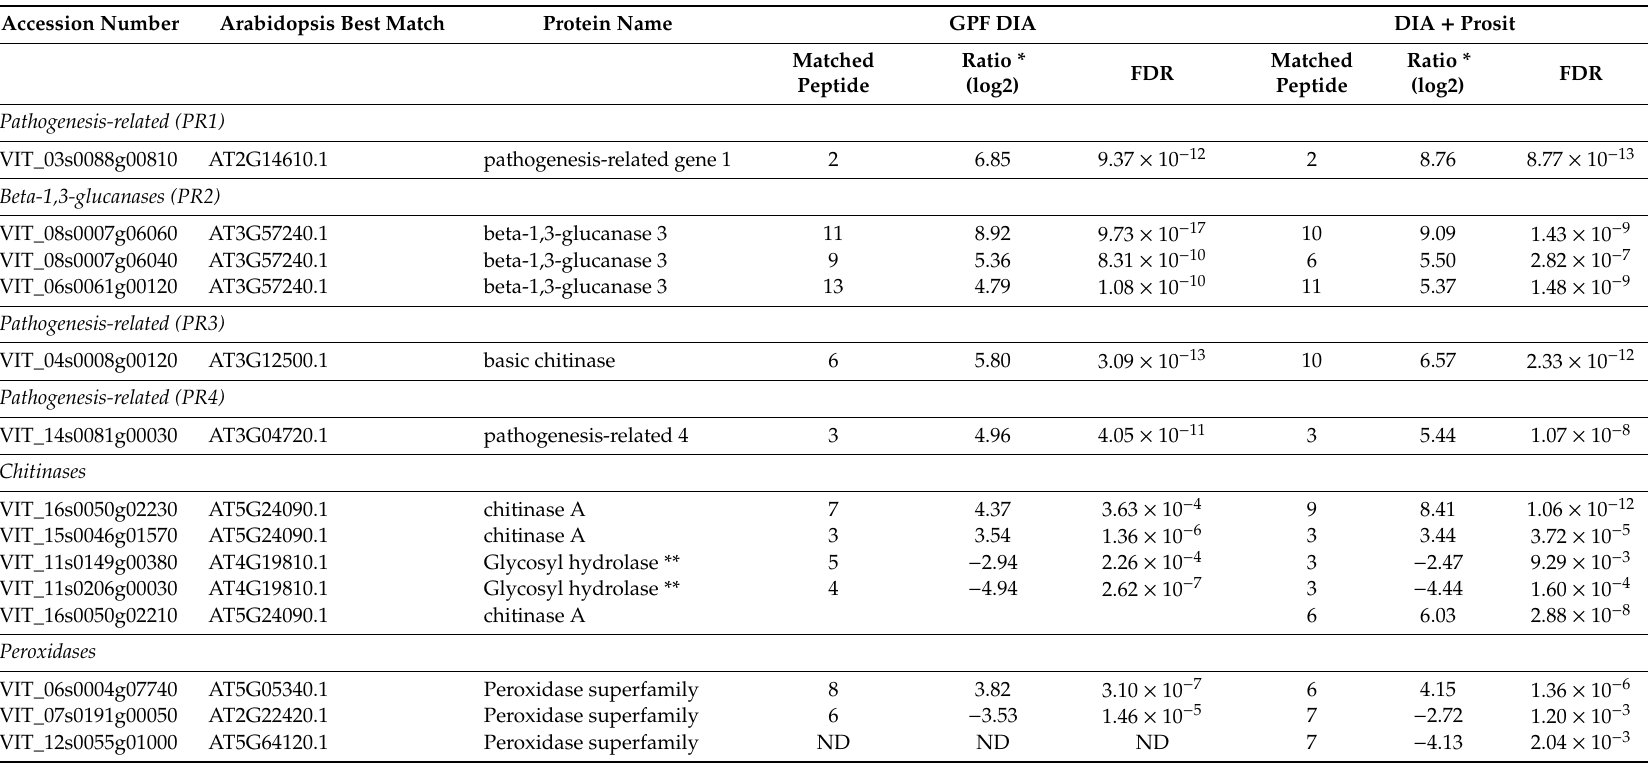
Table 2. Pathogenesis-related (PR) proteins identified in the vascular leaf sap of grapevines showing Pierce’s disease symptoms by GPF DIA and DIA + Prosit with FDR <